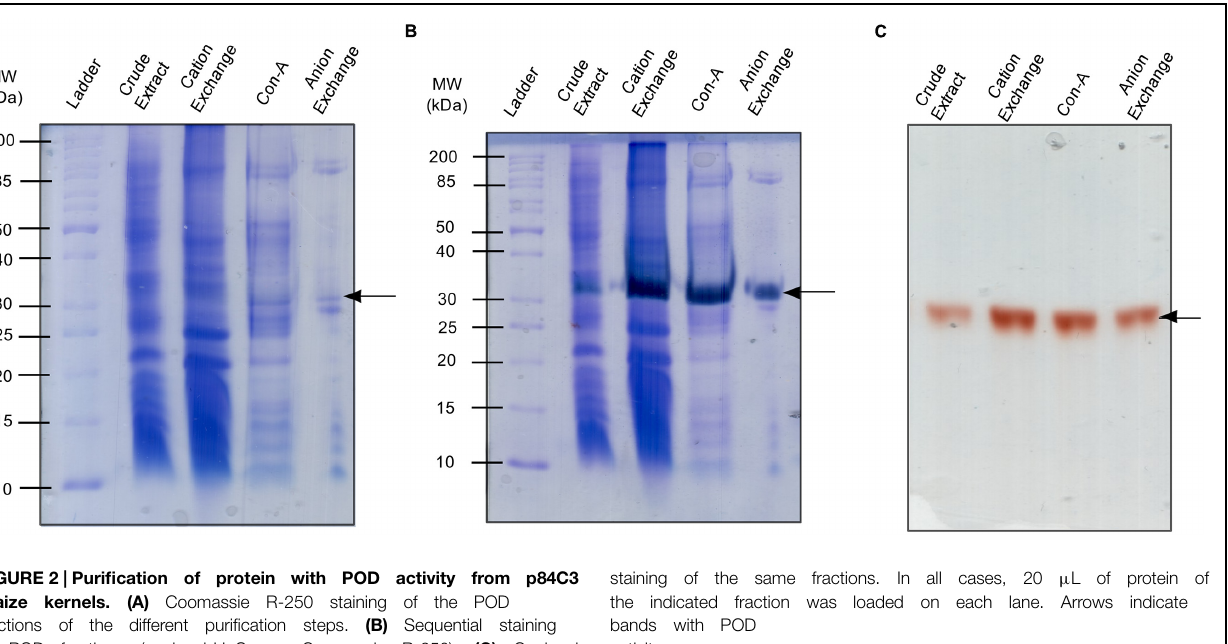
staining of the same fractions. In all cases, 20 µ L of protein of the indicated fraction was loaded on each lane. Arrows indicate bands with POD